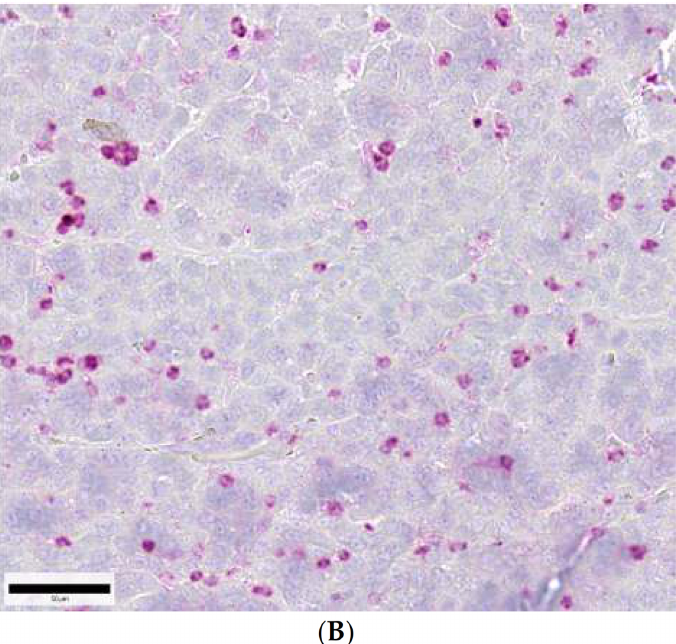
Figure 4. ( A ): Breast cancer dysplasia grade 3 in WAP-T transgenic mice (Syn G3 CD45 135 62.8). Tumor-infiltrating leukocytes were detected thanks to their antibody binding capacity by the an- tibodies (anti CD45) and the streptavidin-alkaline phosphate complex with its specific binding characteristic for CD45 as a pan-leukocyte marker. Leukocytes are considerably detected in all sur- rounding tissues and moderate in the epithelial tumor tissue itself, as shown in this figure ( B ): Breast cancer dysplasia grade 4 in WAP-T transgenic mice (Syn G4 CD11b 13333-3). Tumor-infiltrating natural killer cells (NK cells) were detected by the rabbit monoclonal anti-CD11b and the streptavidin- alkaline phosphate complex with its specific binding capacity for CD11b as an NK cell marker. NK cells are considerably detected in all surrounding tissues and moderate in the tumor tissue itself, as shown in this